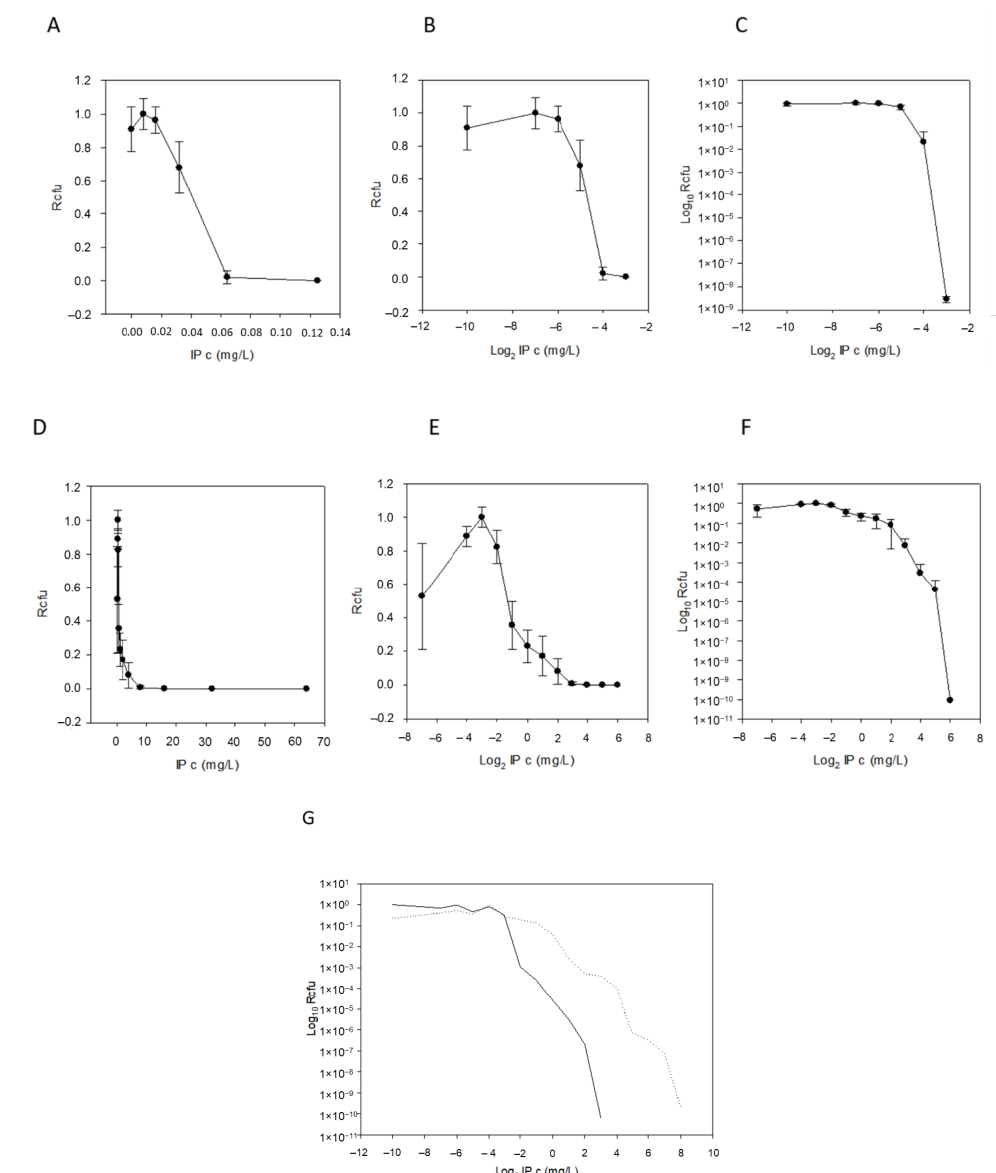
Figure 3. Demonstration of PAP curves. Imipenem concentration vs. growing colony number plots with different scale axes and with error bars for the imipenem susceptible and cfiA -negative B. fragilis NCTC 9342 ( A – C ) and for HR and cfiA -positive B. fragilis CZE60 ( D – F ). Direct plots (hyperbola-like curves, ( A , D )), logarithmic IP concentration (saturation-like curves, ( B , E )) and both axes logarithmic (classic PAP curves, ( C , F )). (To be able to logarithmize zero concentration of imipenem, we used an 8-fold smaller value, such as 0.004 mg/L, instead of 0.032 mg/L). Comparison of the PAP curves of imipenem uninduced (solid line) and imipenem-induced (dashed line) B. fragilis 3130 ( G